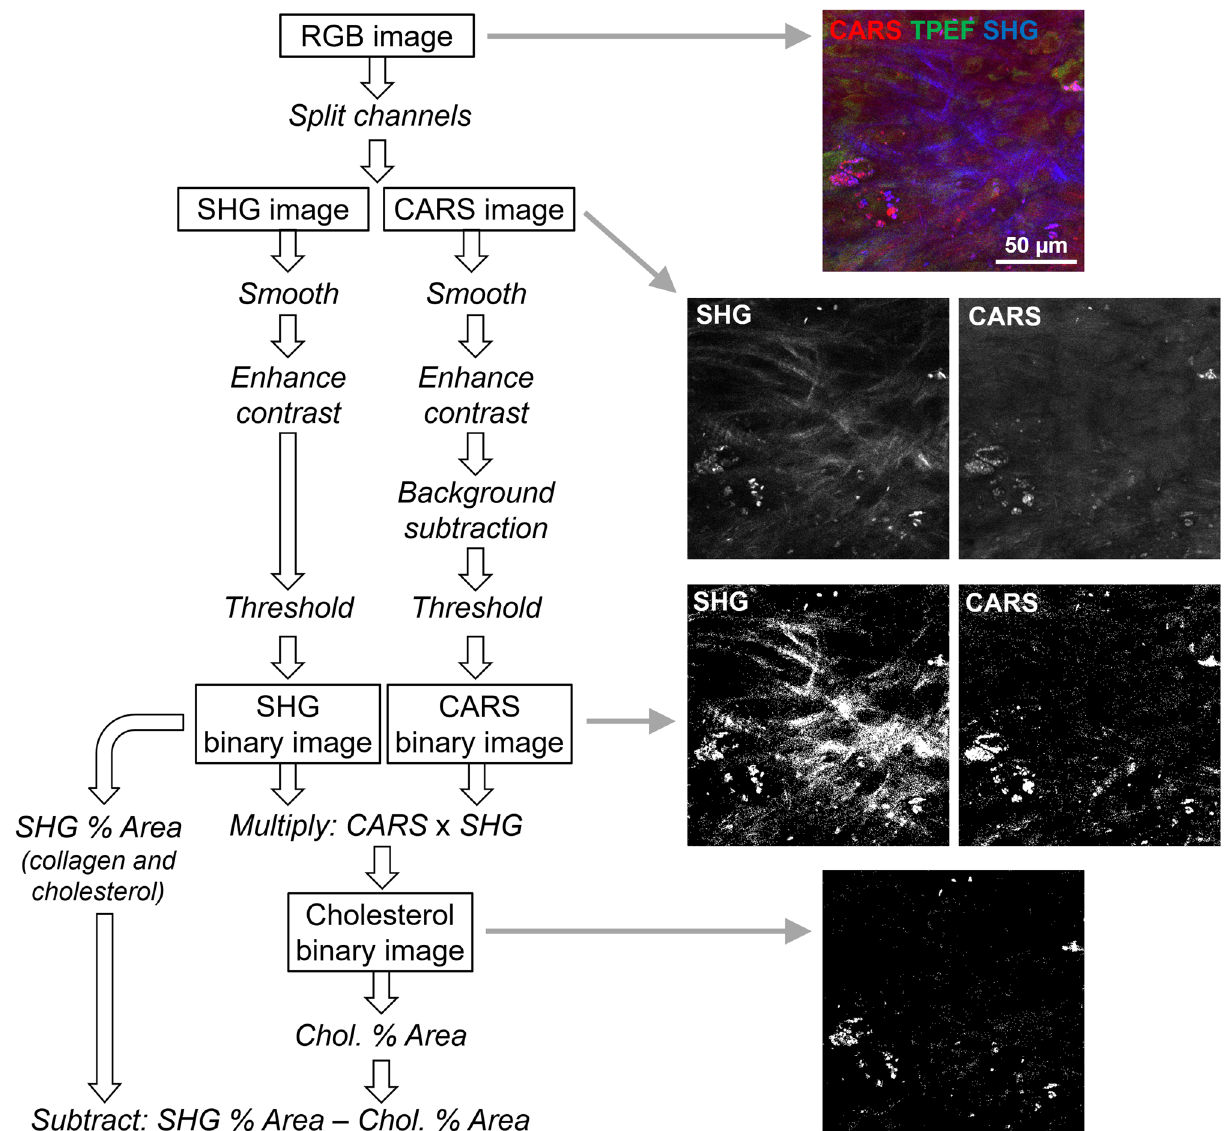
Figure 9. Flow-chart of the image analysis procedure used for collagen quantification in MPM